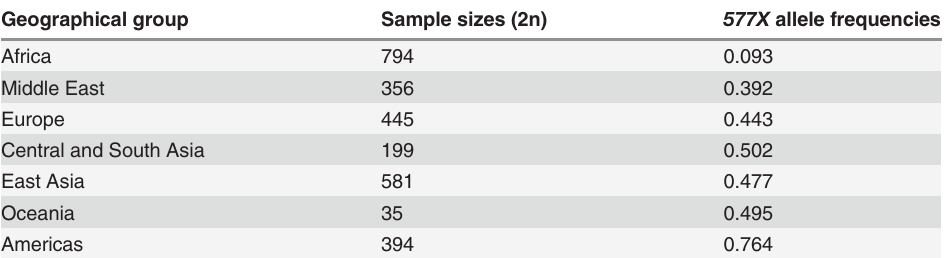
Table 1. Frequencies of the rs1815739 derived allele in autochthonous populations pooled into seven geographical groups.